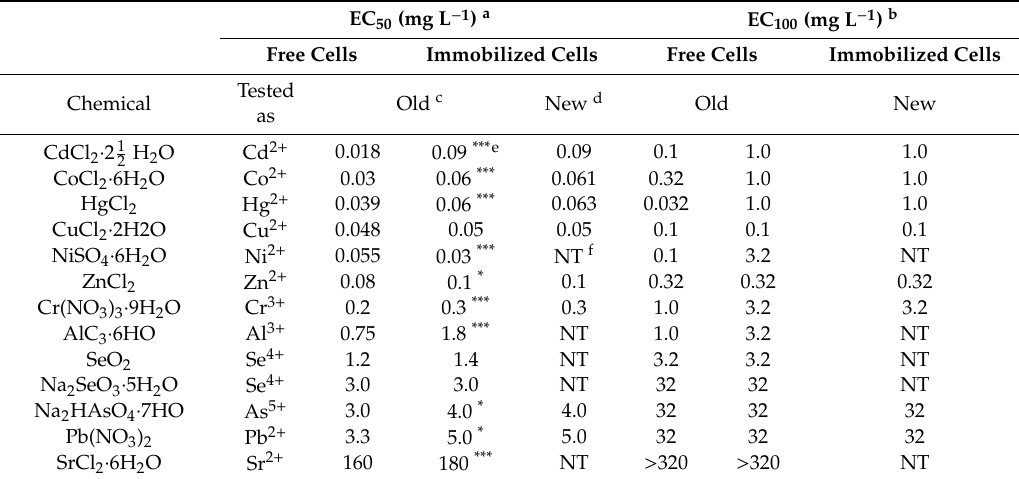
Table 2. Toxicity of some heavy metals on growth of free and alginate-immobilized cells of the test alga Pseudokirchneriella subcapitata , toxicity is reported as mean values of EC 50 and EC 100 (n =